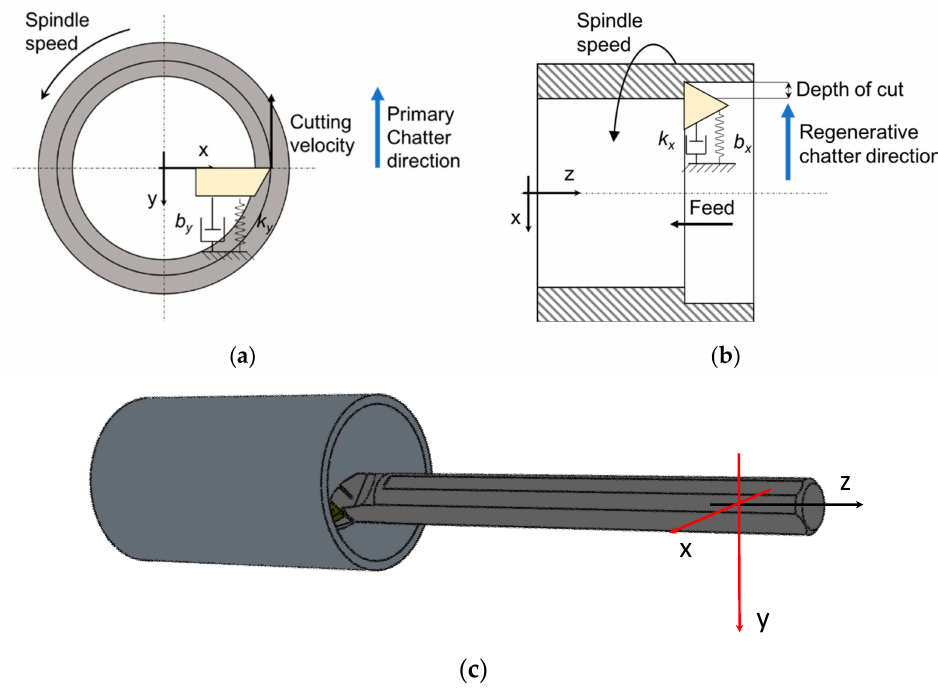
Figure 2. ( a ) Primary chatter; ( b ) regenerative chatter; ( c ) boring bar most flexible directions (red lines).